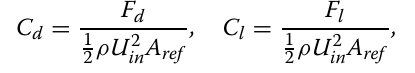
As for the reconstruction of the pressure fields, the additional matrix of weights w b which correspond to the reduced pressure of the unknown input data has been optimized in the PINN training process. Figure 7 depicts the time history of the first four reduced coefficients in the ROM approximation of the missing pressure fields and it shows also the corresponding four coefficients obtained by the L 2 projection of the pressure data onto the pressure POD